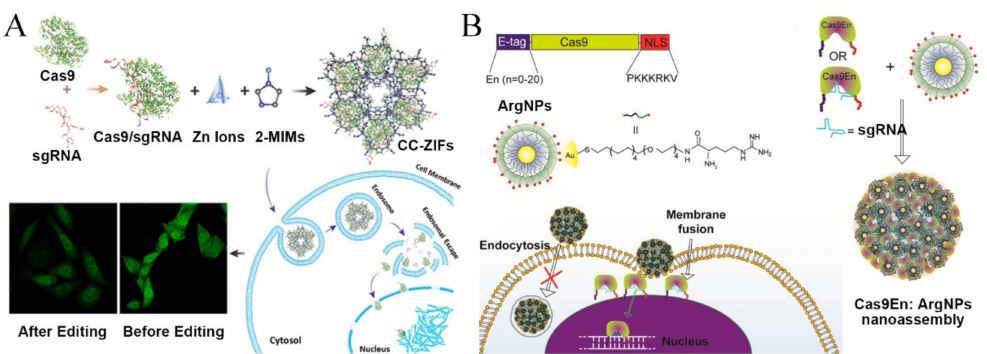
Figure 9. Responsive nanoparticles for endosomal membrane disruption and cell membrane fusion. ( A ) Preparation, cytoplasmic delivery, and gene editing efficiency of Cas9 RNP/ZIF (Reproduced with permission from [66]. Copyright ACS Publications, 2018). ( B ) Rational engineering of Cas9 protein and ArgNPs for intracellular delivery of Cas9-RNP via membrane fusion (Reproduced with permission from [69]. Copyright ACS Publications,